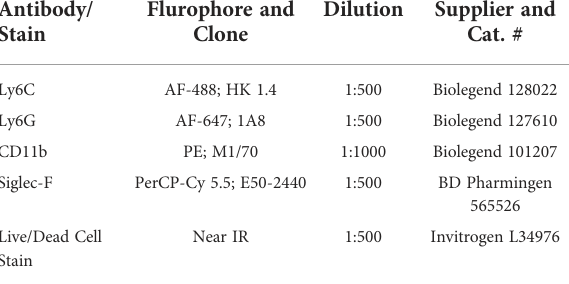
TABLE 1 Antibodies and stains used for fl ow